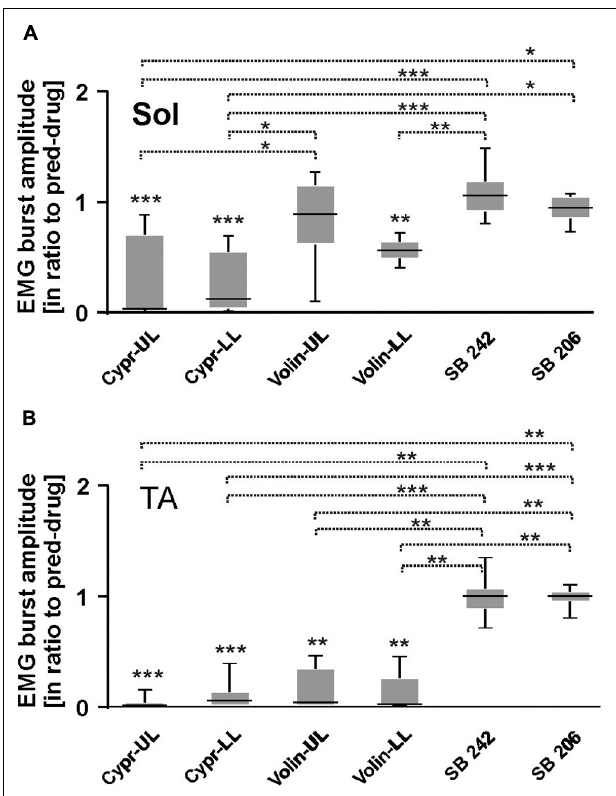
FIGURE 7 | EMG amplitude of soleus (A) , tibialis anterior (B) muscles before and after 5-HT receptor blockage by either Cyproheptadine, Volinanserin, SB 242084 or SB 206553 application in the upper (UL) or low (LL) lumbar spinal cord during plantar- and dorsiflexion established for Sol and TA muscles of both hindlimbs. Note that in the case of soleus EMG activity Cyproheptadine but not Volinanserin application reduced significantly the reflex response to dorsiflexion in the UL rats (A) , while TA EMG response to plantarflexion was reduced by either drug application in both UL and LL rats (B) . Results from left and right muscles were pooled in all the rats in the various experimental conditions, so the number of samples taken for analysis were: Cypr UL n = 12, Cypr LL n = 10, Volin UL n = 10, Volin LL n = 10, SB 242 n = 12, SB 206 n = 10. Sol, soleus muscle; TA, tibialis anterior muscle; Cypr, Cyproheptadine;